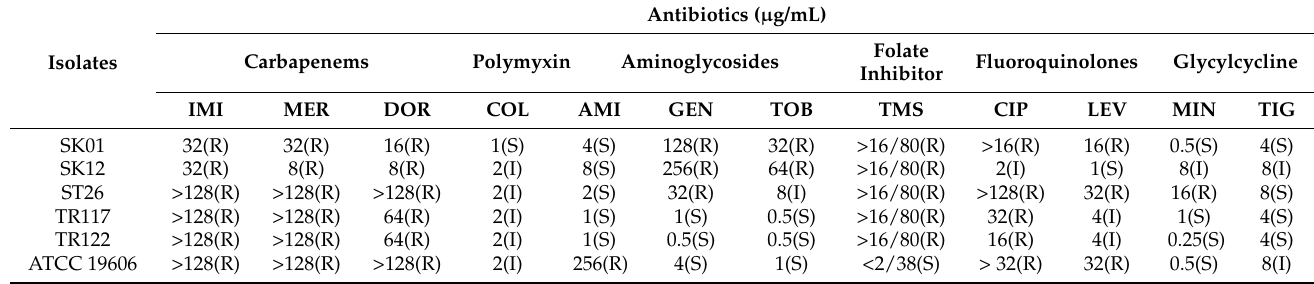
Table 2. Minimum inhibitory concentrations of fosfomycin-resistant A. baumannii isolates against conventional antibiotics.